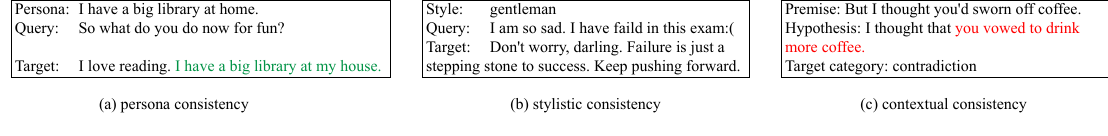
Figure 1. The examples of persona, stylistic, and contextual consistency. In example ( a ), the response contains information that is consistent with persona. For example ( b ), the response presents a gentlemanly style. The purpose of example ( c ) is to determine the consistency between premises and